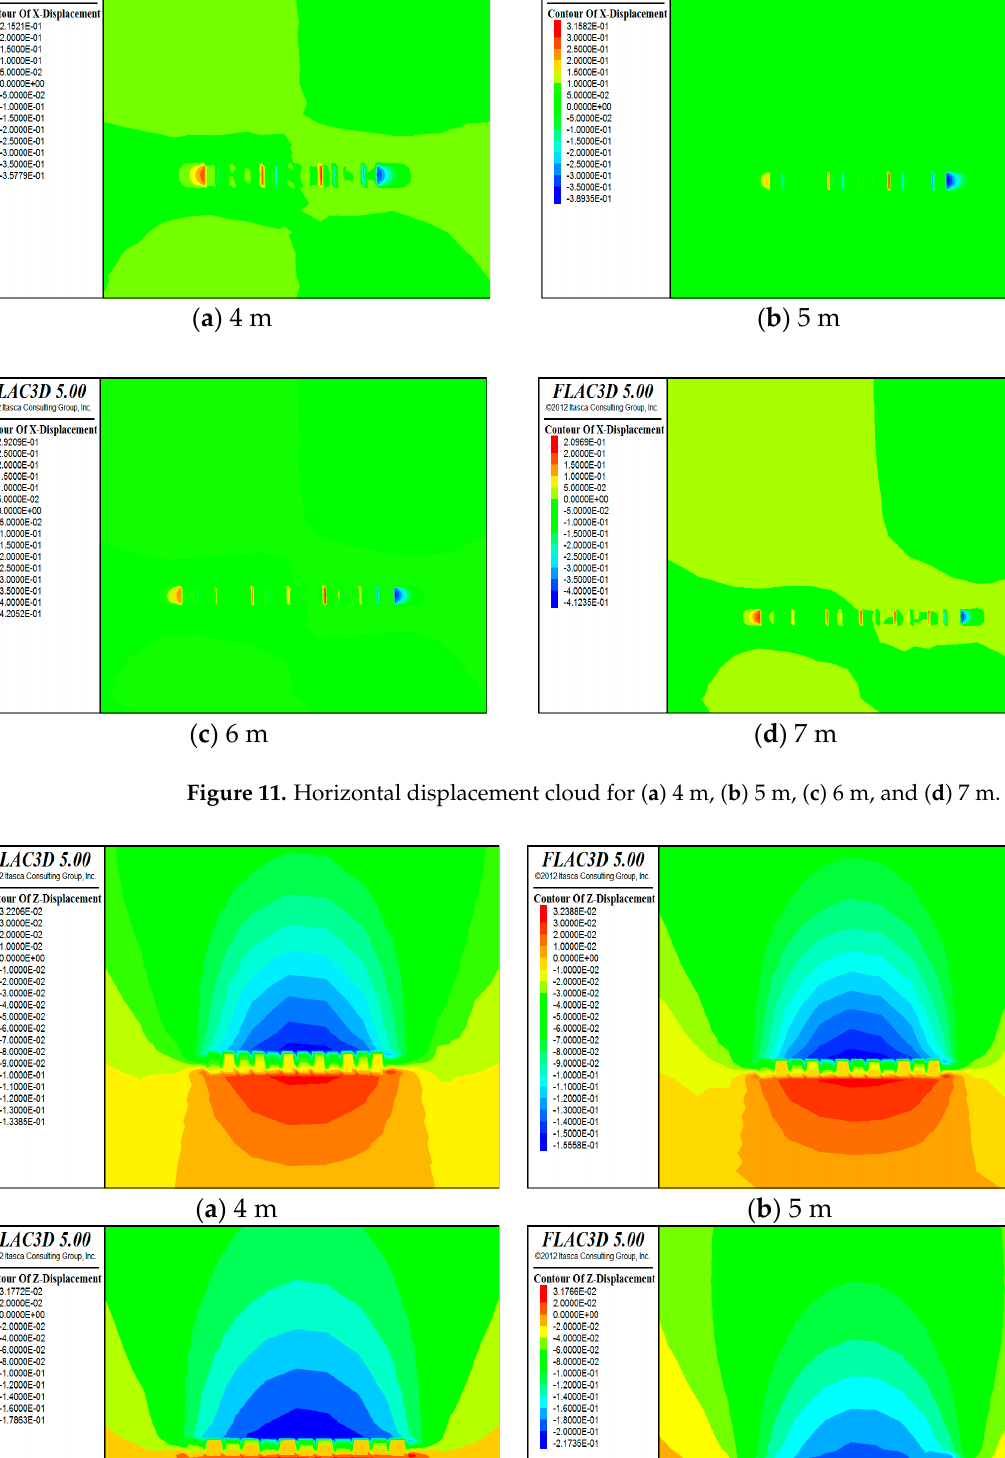
12 of 24 ( d ) 7 m Figure 10. Overburden vertical deformation curve for ( a ) 4 m, ( b ) 5 m, ( c ) 6 m, and ( d ) 7 m. Table 4. Maximum overburden subsidence for different mining width conditions. Rock Location Maximum Overburden Subsidence/mm 4 m Distance/m direct top 11m above coal seam (old top) 78m above the coal seam 289m above coal seam (topsoil) the surface (of the earth)